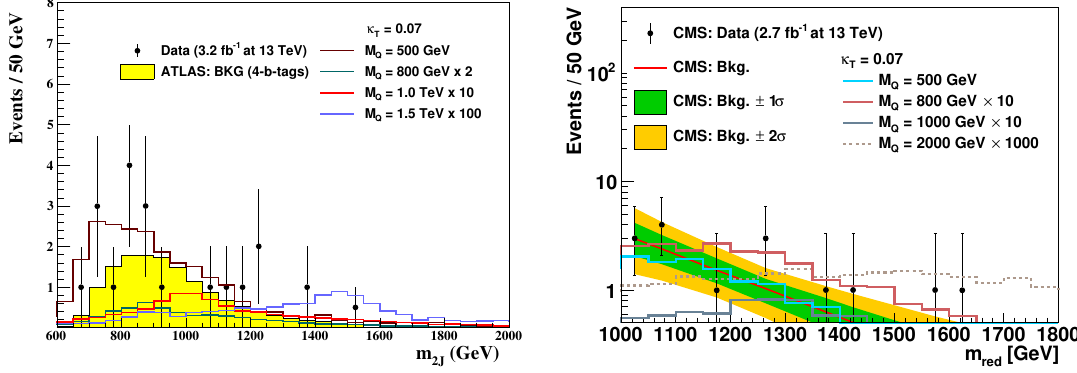
Figure 7 . Distribution in the invariant mass of the system made of the two reconstructed boosted Higgs bosons after applying the boosted ATLAS-like analysis selection (left), and in the reduced mass resulting from the boosted CMS-like analysis (right). We select varied benchmark setups and overlay our predictions with the ATLAS [9] and CMS [12] data and backgrounds, respectively.